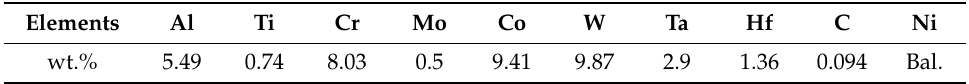
Table 3. The chemical composition of superalloy CM247LC (wt.%).